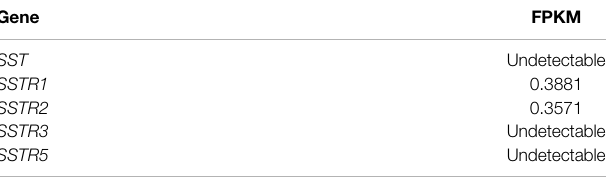
TABLE 1 | Expression of SST and its receptors in porcine left ventricular samples (sham group) measured by mRNA sequencing. Gene FPKM